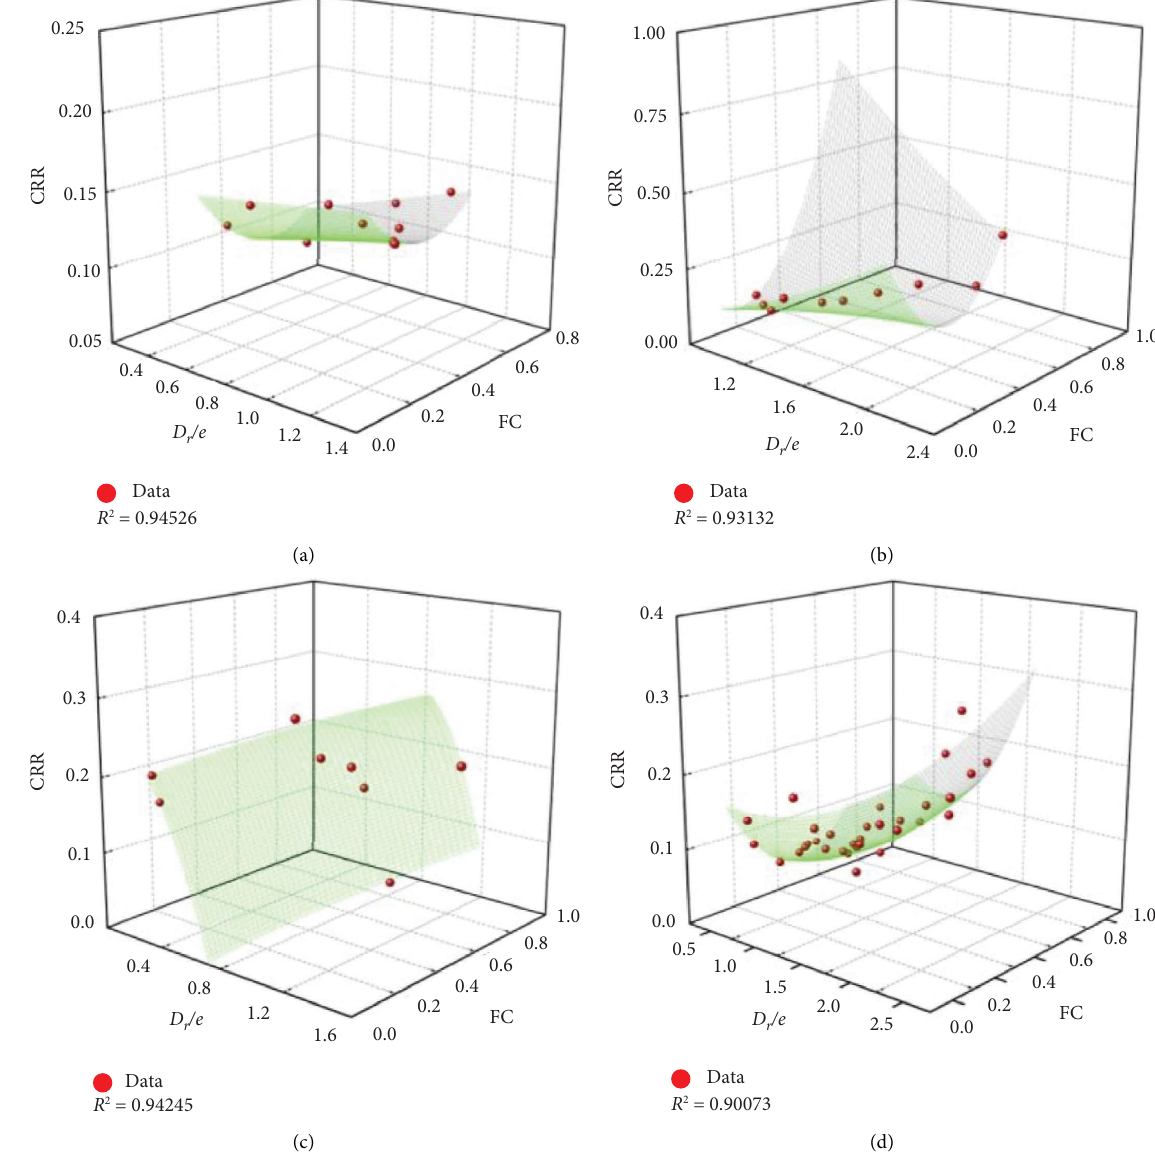
Figure 10: Fitting results based on the semiempirical model. (a) FS. (b) Dash et al. (c) Polito et al. (d) Sitharam et al. Table 3: Fitting parameters for the test